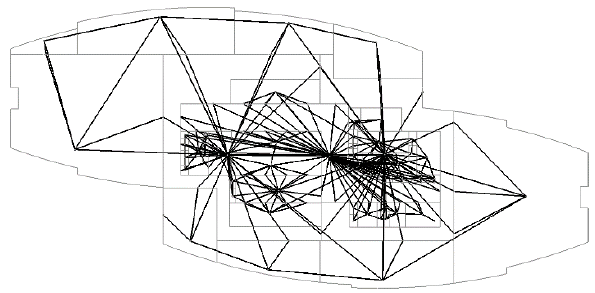
Figure 2. Building logical